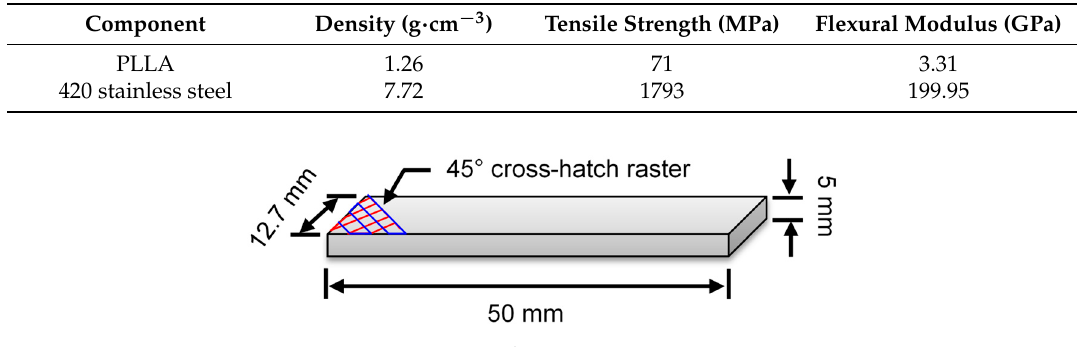
Figure 2. 3D printed PLLA-SS420 composites.